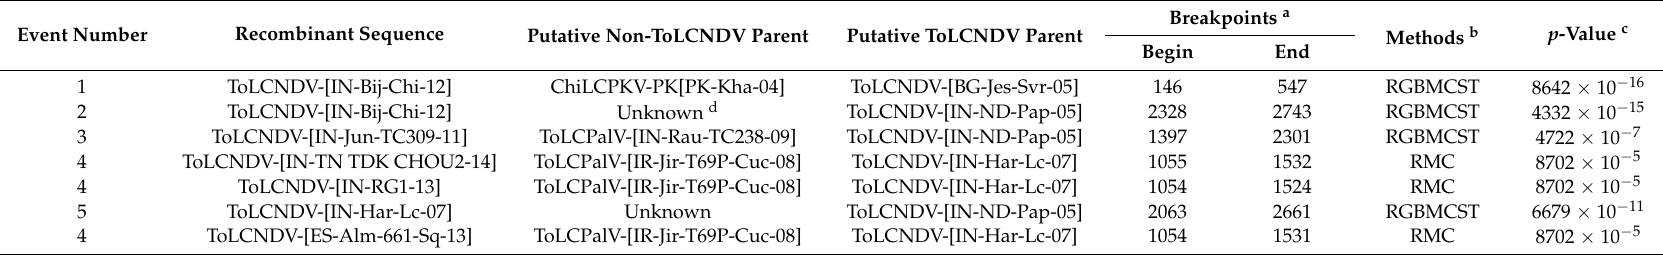
Table 2. Major recombination events detected among isolates of ToLCNDV that differ with reported ones at the strain threshold level noticed using the Sequence Demarcation Tool (SDT) analysis (highlighted with asterisks in Figure 3) and isolates of closely-related begomoviruses putatively involved in the recombination